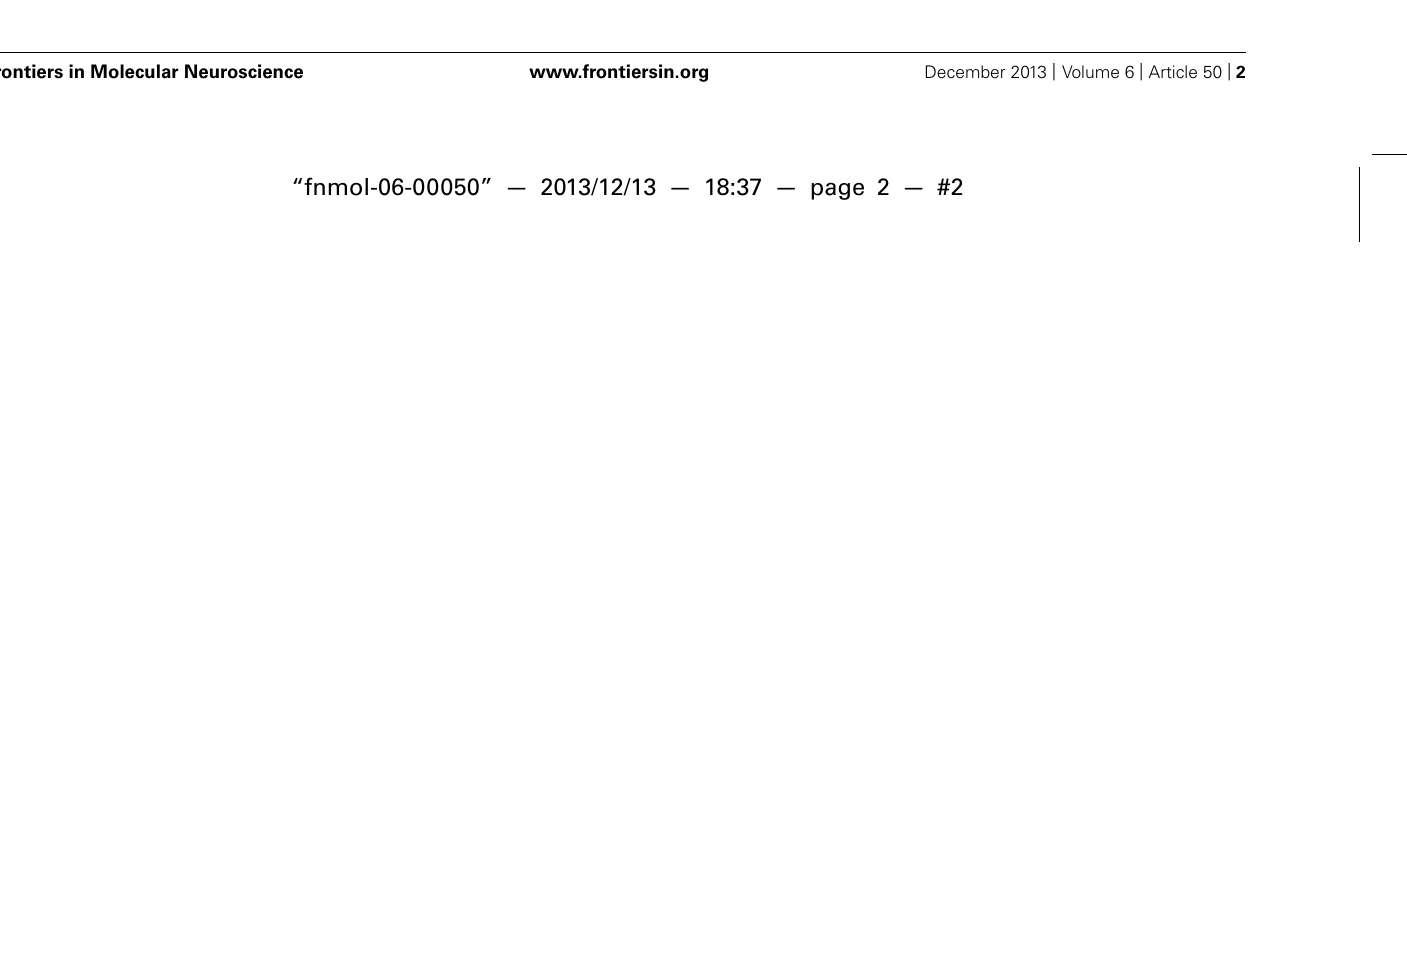
FIGURE 1 | (A) Non-invasive brain stimulation by transcranial magnetic stimulation (TMS). A single TMS pulse of sufficient intensity applied over the primary motor cortex hand area through a TMS coil (asterisk) induces a muscle contraction in the contralateral hand and elicits a motor-evoked potential in the target muscle. Repetitive TMS (rTMS; i.e., trains of several 100 pulses) can change cortical excitability for hours beyond the stimulation period, which has driven interest toward a therapeutic use of